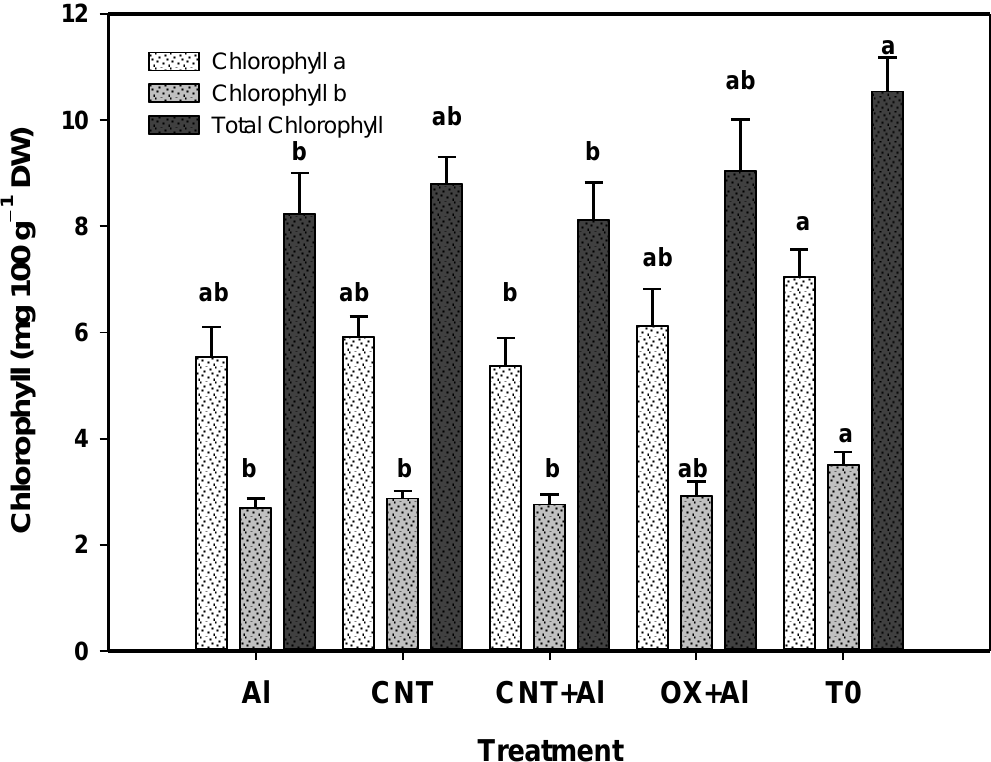
Figure 4. Chlorophylls content in leaves of tomato plants. Al: Positive control inoculated with A. solani ; CNT: Carbon nanotubes; OX: Commercial control; T0: Control. Different letters indicate significant differences between treatments according to the least significant difference of Fisher test (α = 0.05). N = 5 ± standard error.